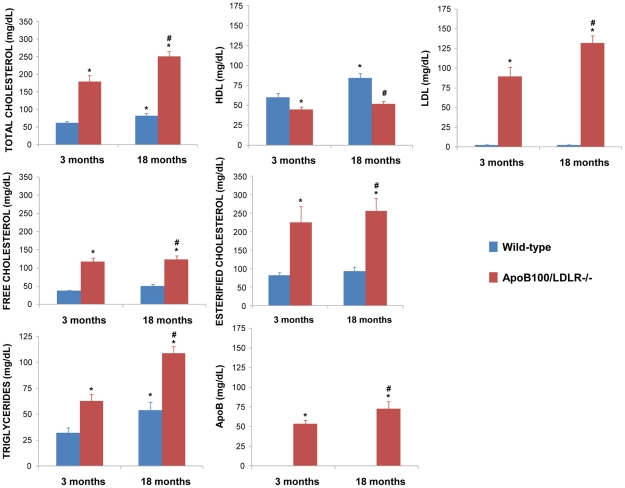
Values of plasma variables in young and aged wild-type and transgenic mice.Total cholesterol, HDL-cholesterol, LDL-cholesterol, apoB and triglycerides were assessed by spectrophotometric methods (blue bar  =  wild-type, red bar  =  transgenic). Free and esterified cholesterol were determined by fluorometric assays. The results, expressed in mg/dL, are means±SEM (n≥6 per group). *Significantly different (P<0.05) compared to 3-month-old wild-type mice; #Significantly different (P<0.05) between wild type and transgenic mice.